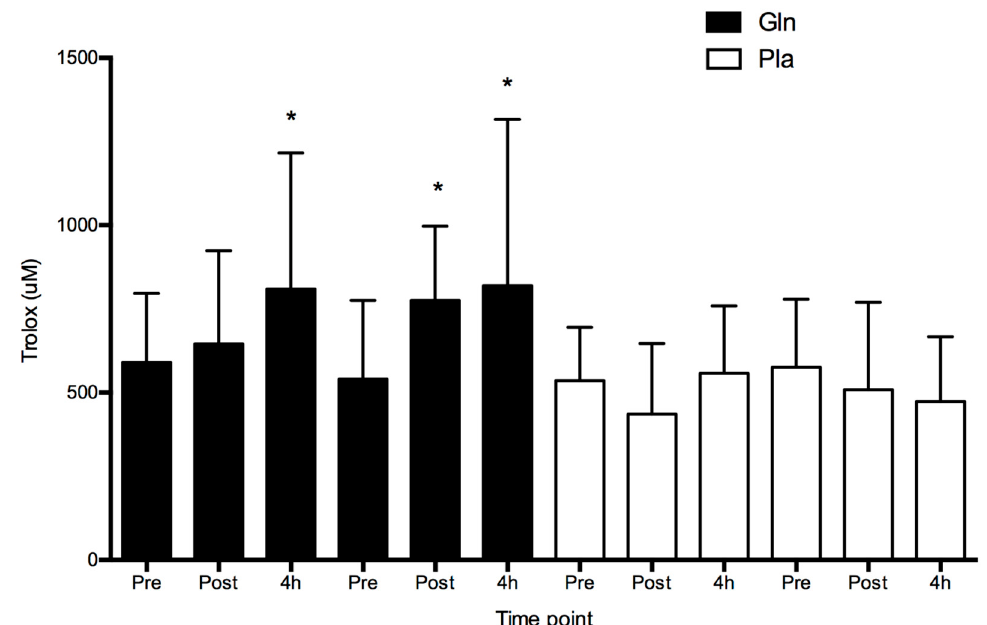
Figure 4. Plasma Trolox. Measurement of antioxidant capacity of the serum was higher at 4 h post on Day 1 (Ex 1), and immediately post as well as 4 h post on Day 2 (Ex 2) in the Gln trial compared to the baseline. Values were not higher in the Pla trial. * p < 0.05 significance compared pre-time point. Data are mean ± SD, n = 8.